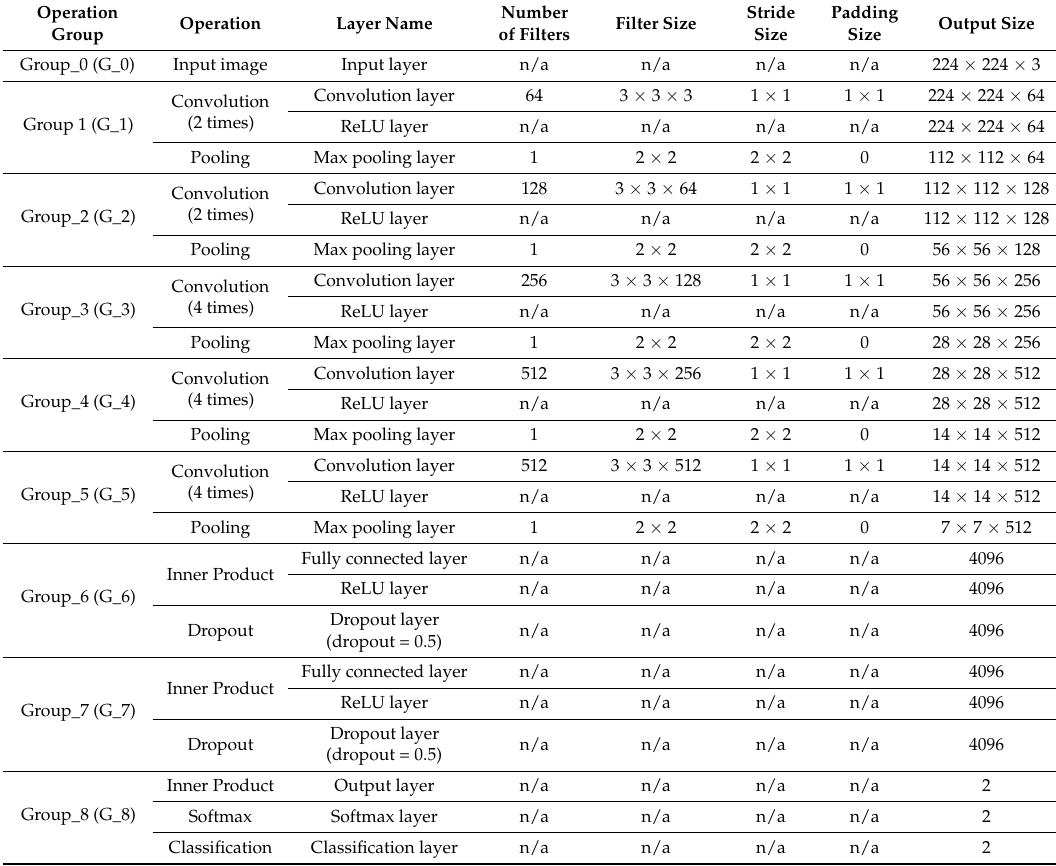
Table 2. Description of CNN architecture used for iPAD in our study.